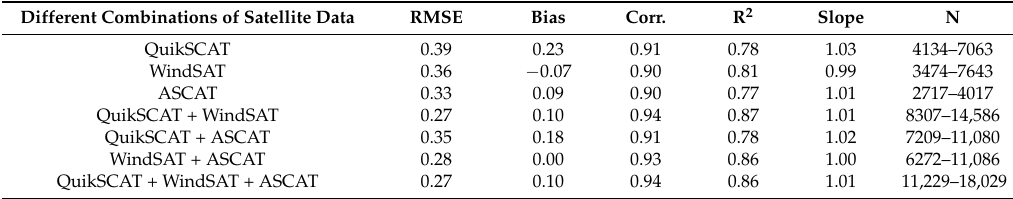
Table 2. Statistics of the comparison between buoy-derived mean wind speeds (MWS) and satellite-derived MWS (m/s) at a height of 10 m above sea level. Different Combinations of Satellite Data RMSE Bias